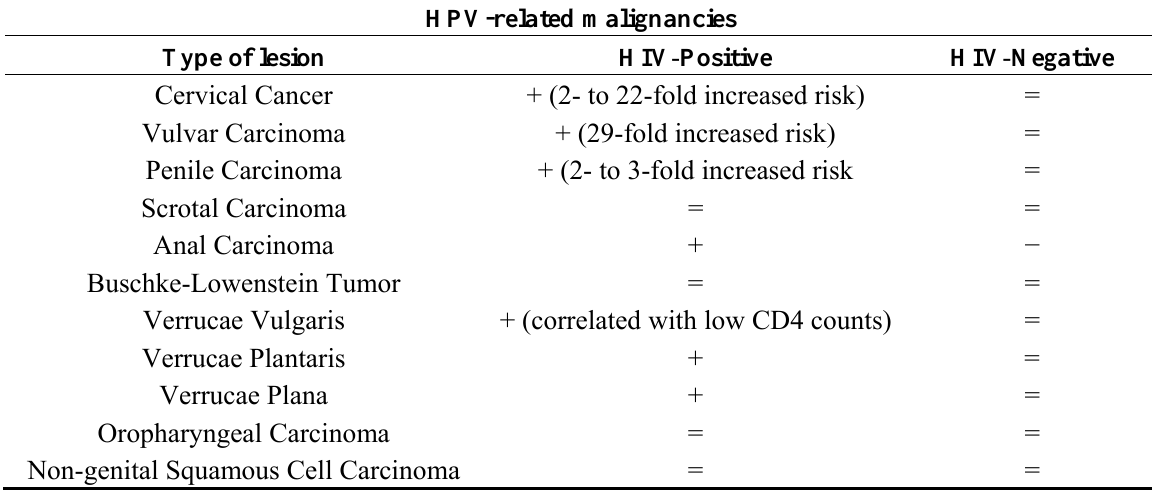
Table 1. Common HPV-related malignancies in HIV-positive and HIV-negative individuals. +, positively correlated increased risk; =, no apparent increased risk; − , rarely encountered/negatively correlated increased